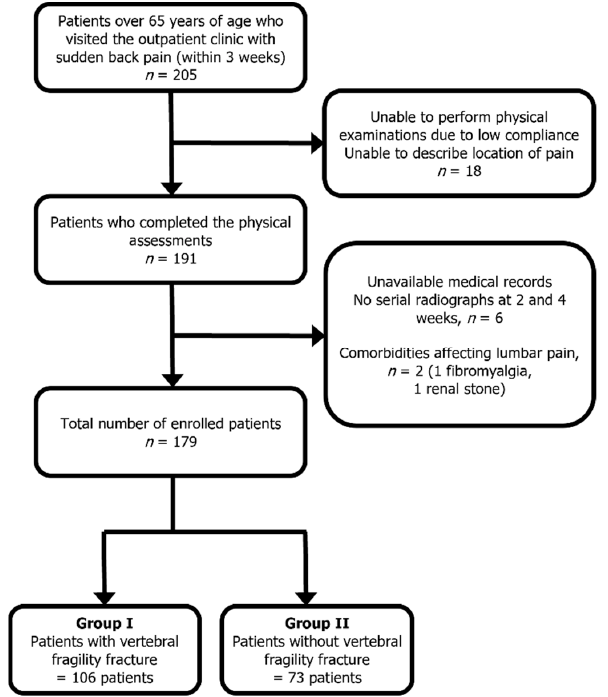
Figure 1. Flowchart of patient selection with inclusion and exclusion criteria.